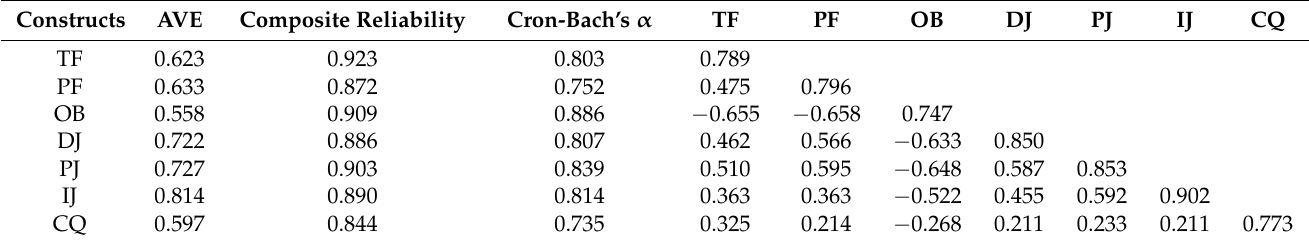
Table 3. Evidence of reliability, convergent validity, and discriminate